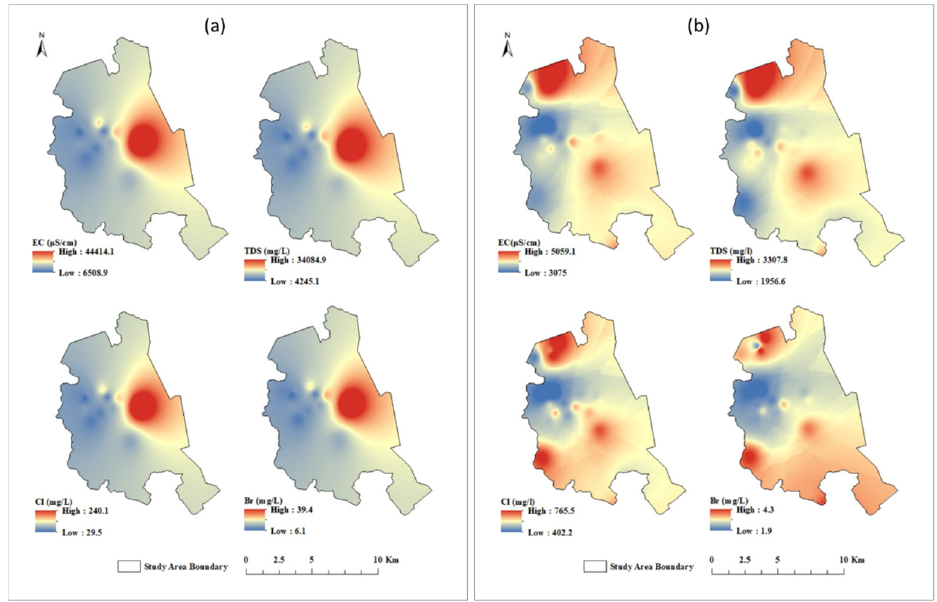
Figure 7. Spatial distribution maps of EC, TDS, Cl − , and Br − for ( a ) shallow GW and ( b ) deep GW.